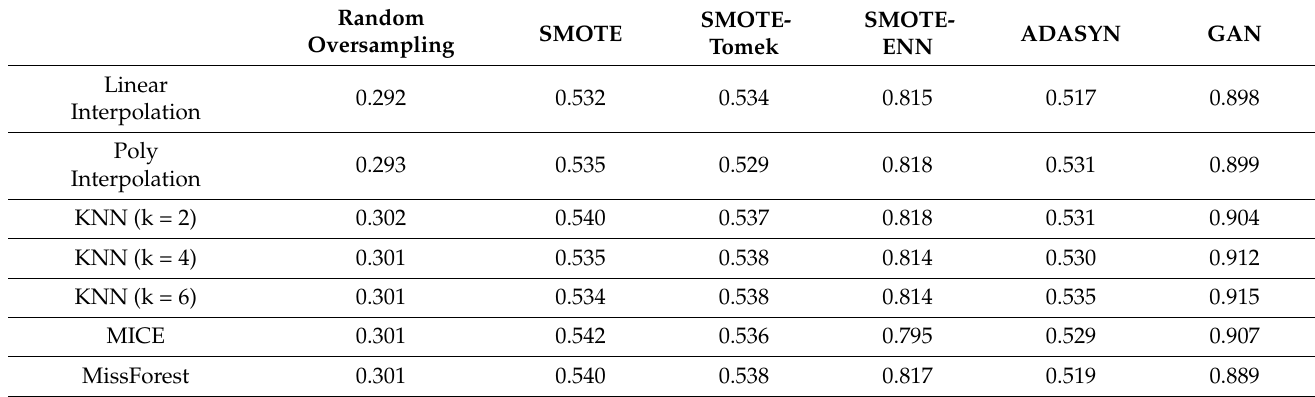
Table 7. Quality